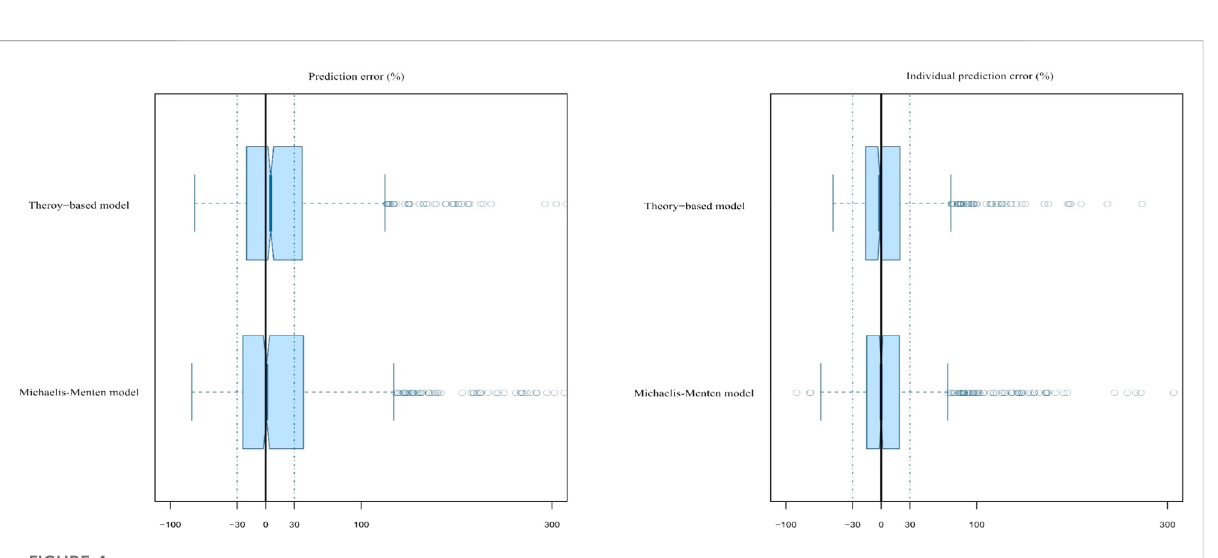
Figure 3B, Supplementary Table S3 show the NPDE results.